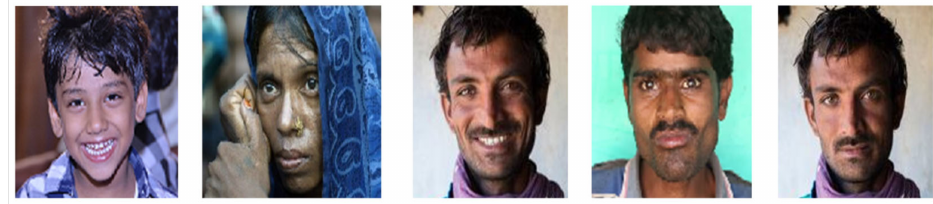
Figure 2. Human faces with